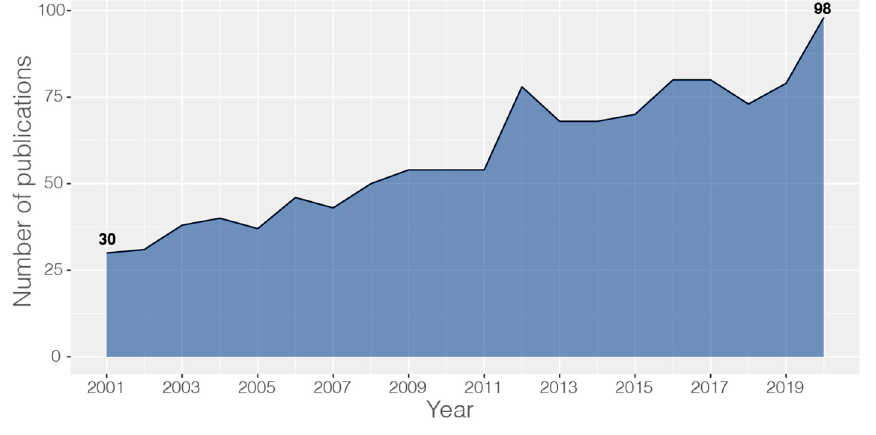
Figure 2. Number of scientific documents published annually on riparian zones (2001–2020). Yet, these journals did not always correspond to the top 10 most highly cited docu- ments (Table 1). For example, the document with the highest number of citations (676) was published in Freshwater Biology (Baxter et al., 2005 [57]), which is not listed above. Additionally, the five most cited sources were the journals Ecology (1247 citations), Journal of Environmental Quality (772), Journal of Hydrology (722), Water Resources Research (716), and Biogeochemistry